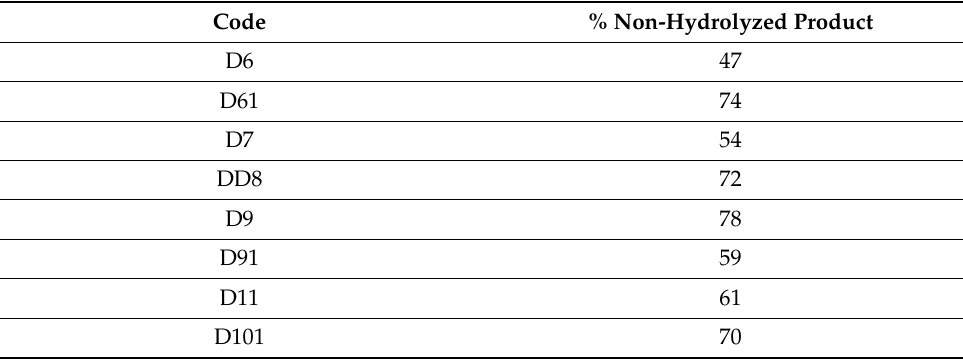
Table 6. Hydrolytic stability of newly synthesized peptides at pH 9.0 for 24